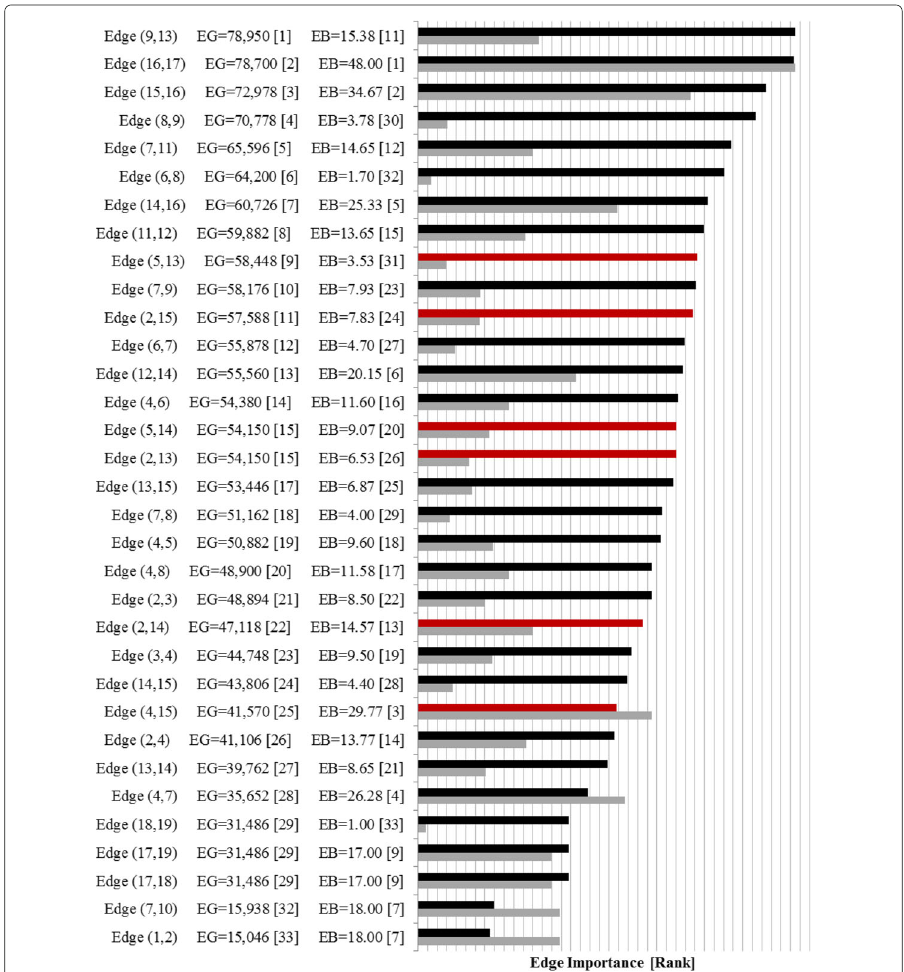
Fig. 21 Edge Gravity (EG) and Edge Betweenness (EB) solutions for the augmented Krebs network